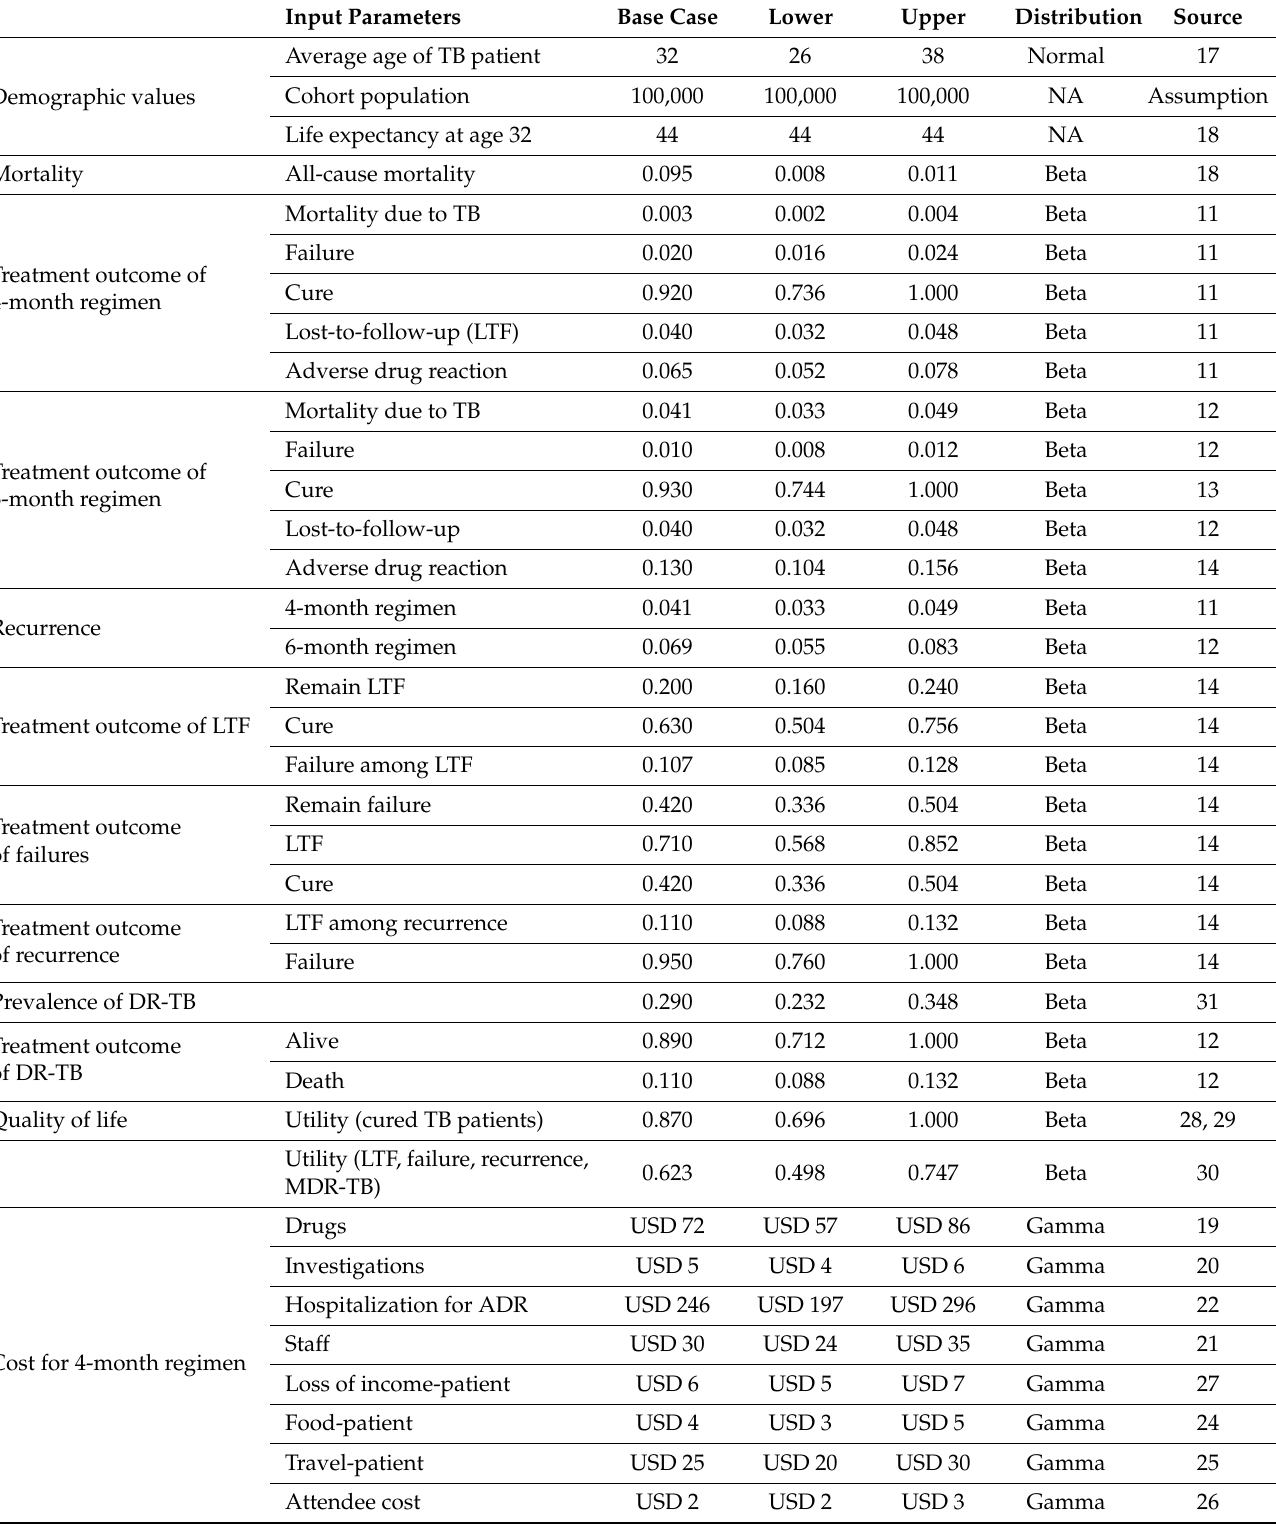
Table 1. Input parameters used for cost-effectiveness analysis of the 4-month shortened treatment regimen as first-line treatment as compared to the 6-month